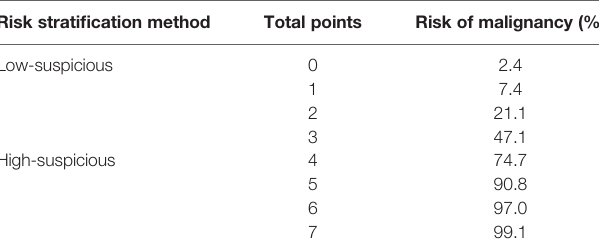
TABLE 6 | Risk strati fi cation according to the malignancy risk of each total